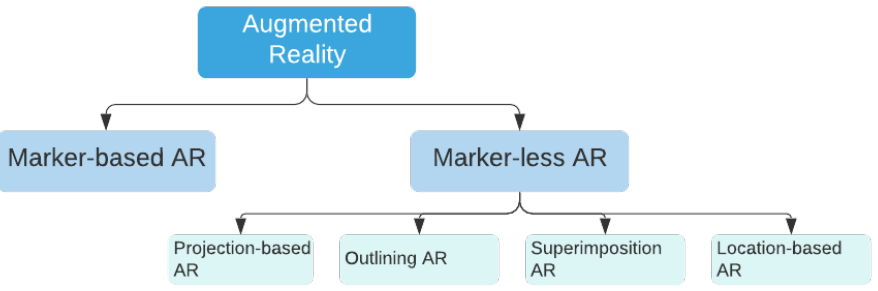
Figure 1. Types of augmented